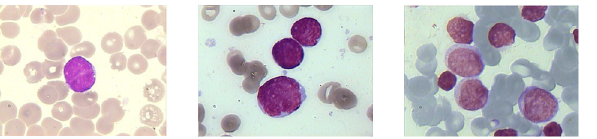
Fig 1. Examples of images with a Wright stain preparation, but with color differences in cells and